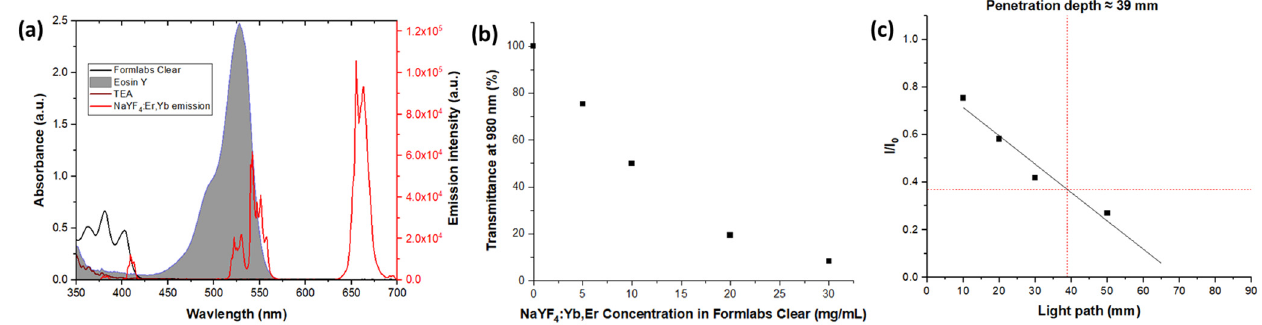
Figure 4. ( a ) Absorption spectrum of the photoinitiation system matched with phosphor emissions; ( b ) transmittance @ 980 nm of resin formulation with different NaYF 4 : (20%)Yb 3+ , (3%)Er 3+ loadings; ( c ) transmittance @ 980 nm of 5 mg mL NaYF 4 : (20%)Yb 3+ , (3%)Er 3+ loading at different path lengths.